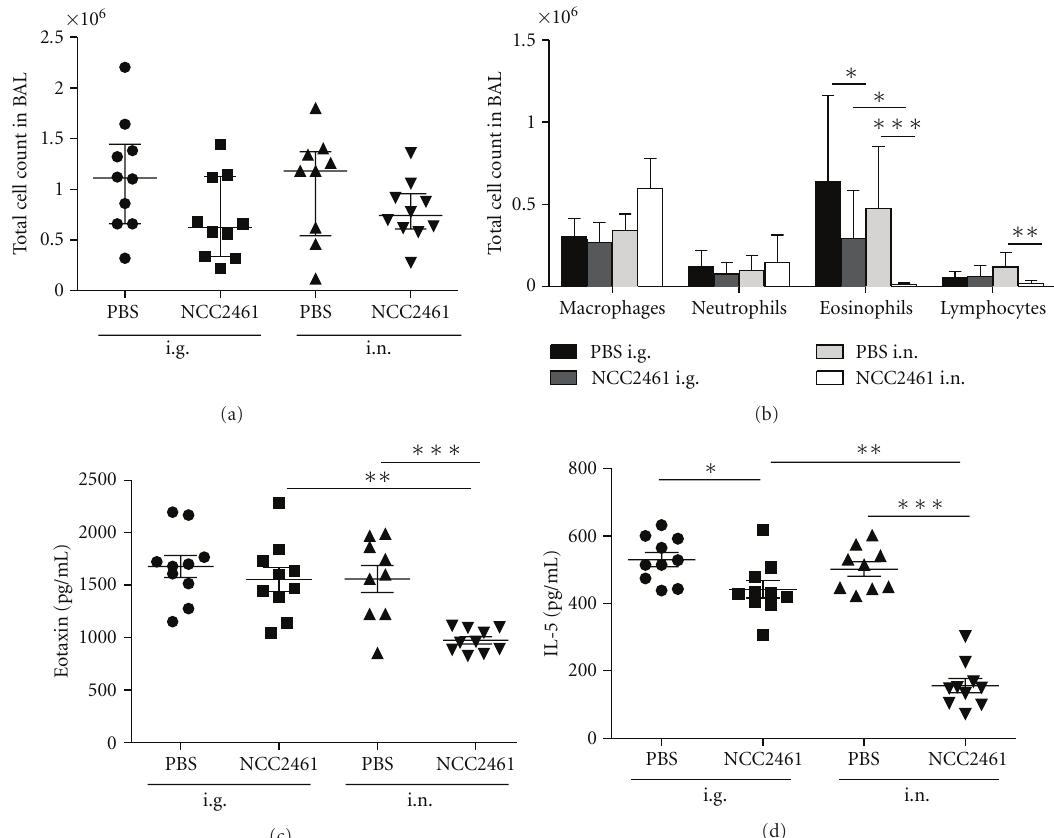
Figure 2: E ff ect of intragastric versus intranasal L. paracasei NCC2461 administration on lung airway inflammation. L. paracasei NCC2461 (1 × 10 9 CFU) or PBS were either administered intragastrically (i.g.) or intranasally (i.n.) in OVA-challenged mice. Total cell counts (a) and di ff erential cell counts (b) in the BALF. Eotaxin (c) and IL-5 levels (d) in lung homogenate were quantified by ELISA. Histograms are mean ± SD obtained from one representative experiment, n = 10 mice per group; ∗ P < 0 . 05, ∗∗ P < 0 . 005, ∗∗∗ P < 0 .